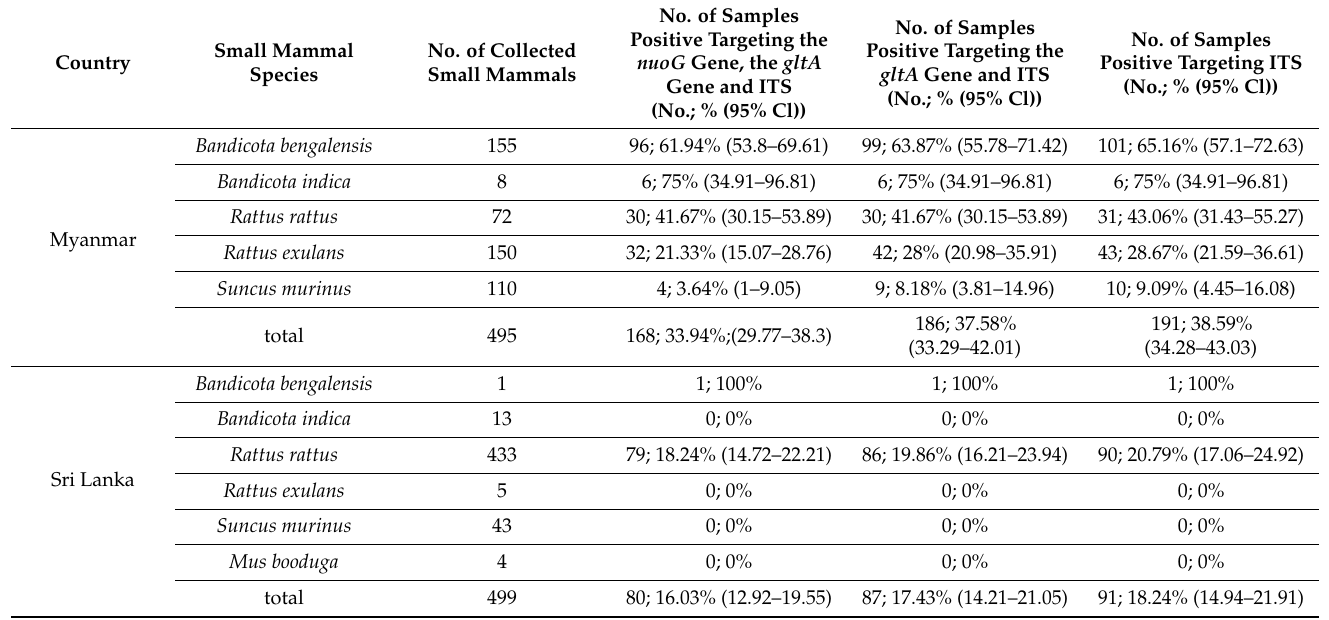
Table 3. Prevalence of Bartonella spp. DNA in small mammals from Sri Lanka and Myanmar targeting the nuoG , gltA gene and the 16s rRNA 23s rRNA